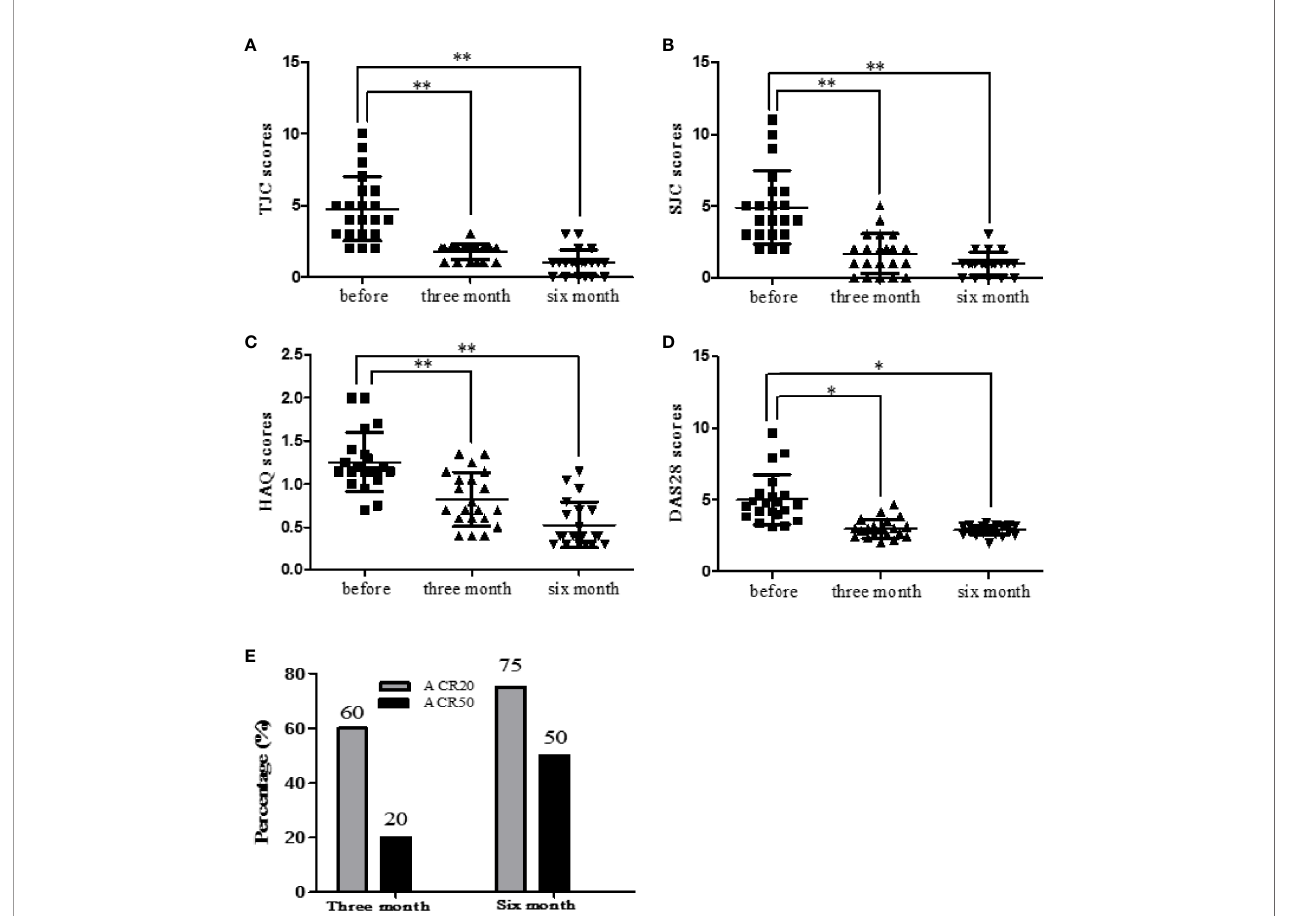
FIGURE 4 | Etanercept down-regulates clinical indicators (HAQ, SJC, TJC, and DAS28) in patients with RA. (A) Change in the level of TJC scores after etanercept treatment. (B) Change in the level of SJC scores after etanercept treatment. (C) Change in the level of HAQ scores after etanercept treatment. (D) Change in the level of DAS28 scores after etanercept treatment. (E) Treatment with etanercept, the percentage of RA patients who have improved to ACR20 and ACR50 standards. * p < 0.05, ** p <